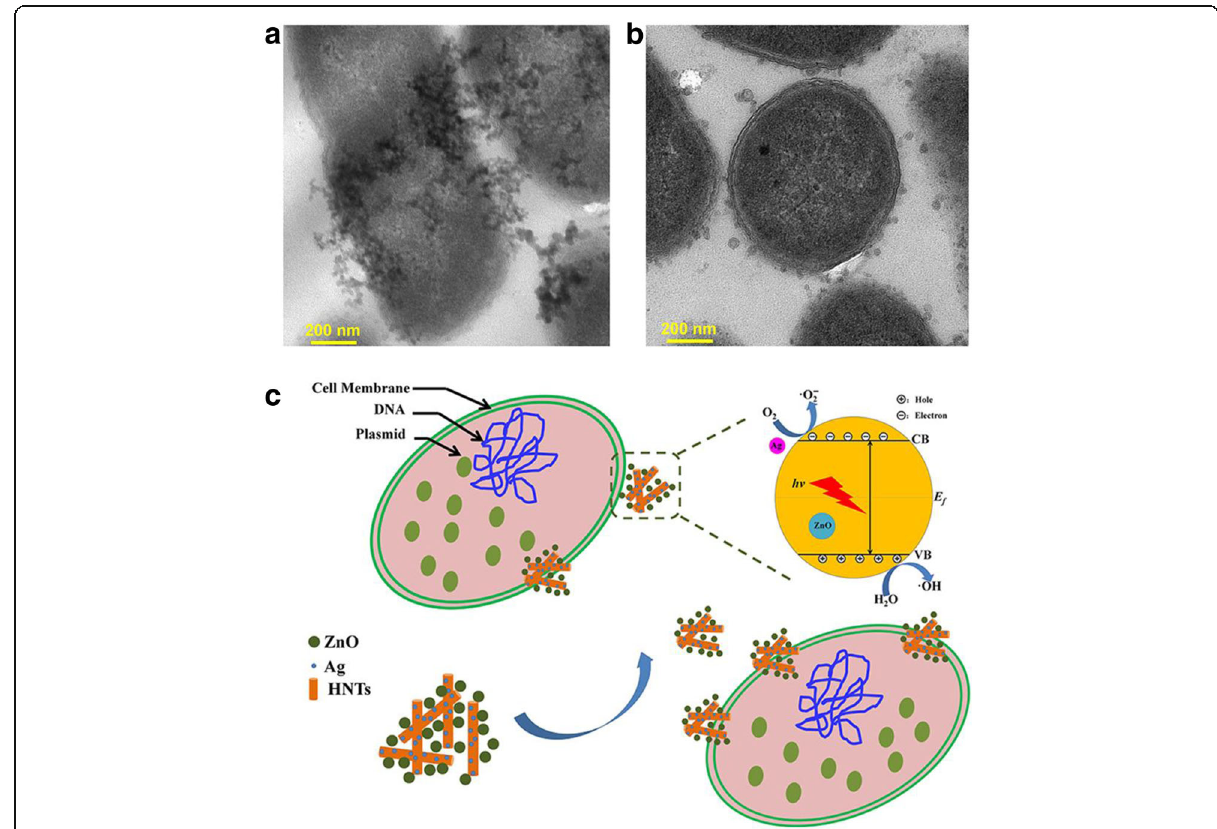
Fig. 5 a , b TEM observations of Ag-ZnO/HNTs nanocomposites absorption in bacteria E. coli and c schematic diagram for enhanced antibacterial